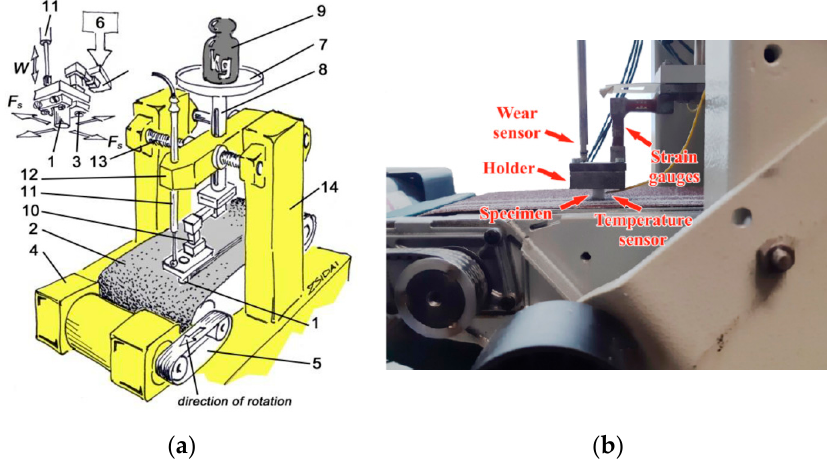
Figure 1. Schematic figure ( a ) and a photo ( b ) about the abrasive pin-on-plate test system. (1) polymer specimen; (2) abrasive cloth; (3) nuts and clamp; (4) electrical motor; (5) twin roll driving system; (6) manual loading system; (7) plate; (8) vertical column ; (9) dead loading weights; (10) strain gauges; (11) linear gauge (for vertical displacement as a result of wear); (12) console head unit; (13) spindle for cross movement (it wasn’t used for present tests). Table 1. Features of the twelve test conditions in the abrasive pin-on-plate test system. Test System No.